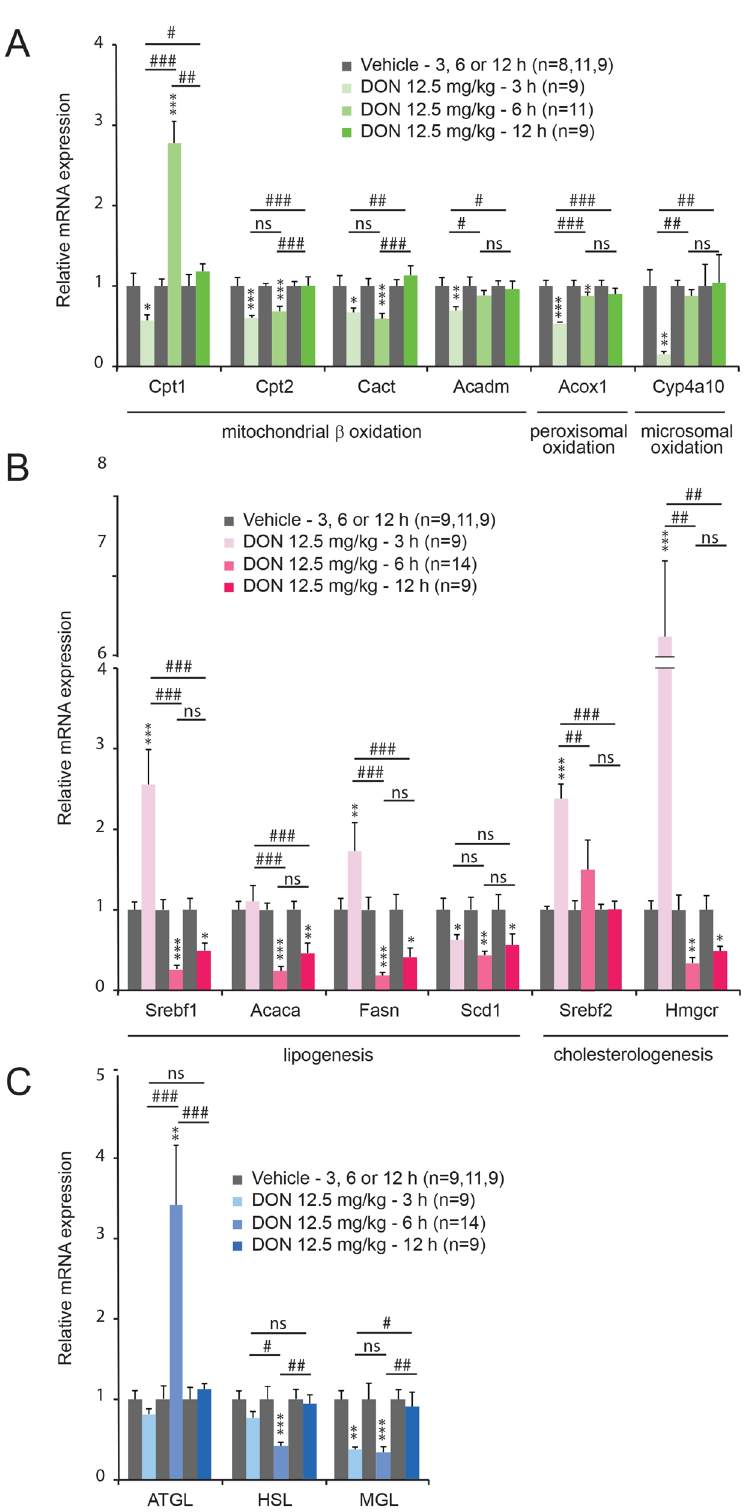
Figure 6. mRNA expression of the indicated FAox ( A ), lipogenic and cholesterologenic ( B ) and lipolytic ( C ) genes was assessed by qRT-PCR from the livers of control and DON-challenged animals for the indicated times. Significances were determined relative to control animals. A two-way analysis of variance test was performed between time series (3, 6 and 12 h) of DON-treated and untreated mice. * P < 0.05, ** P < 0.01 and *** P < 0.001 significantly different from control mice. # P < 0.05, ## P < 0.01 and ### P < 0.001 significant difference between time point of DON-treated mice. ns: no significant